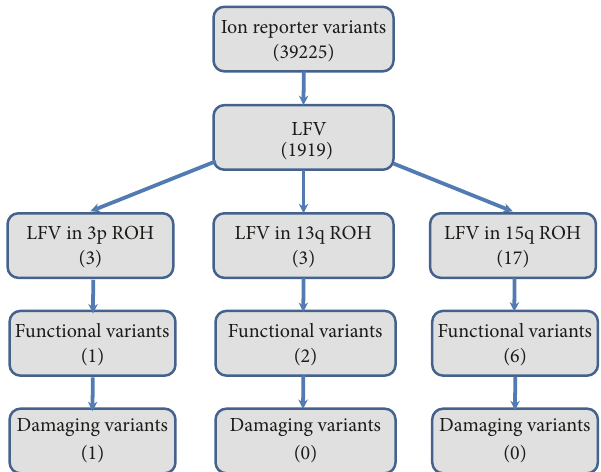
Figure 4: Pipeline for filtration of the damaging